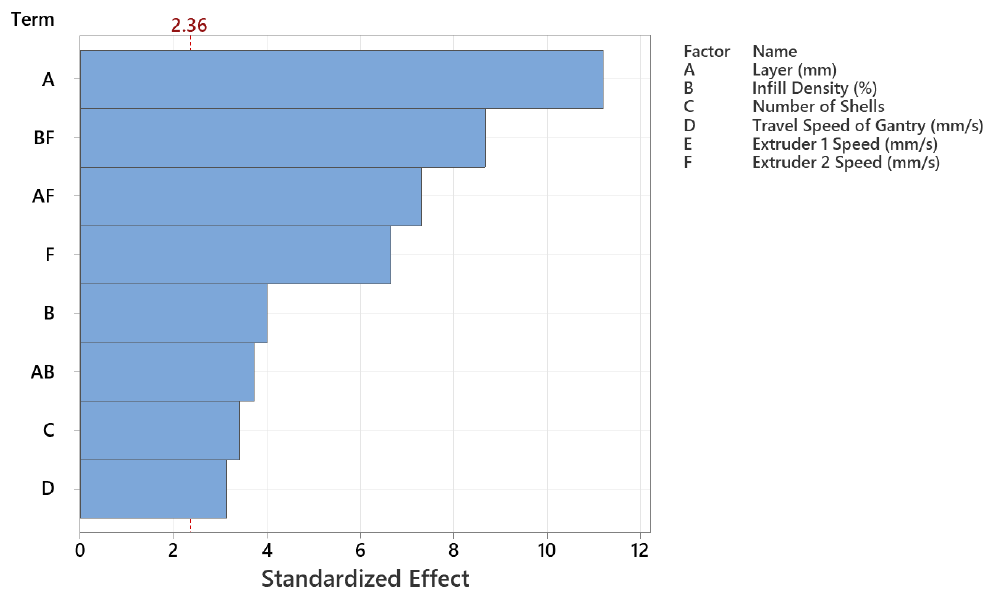
Figure 6. Pareto chart of the standardized effects .